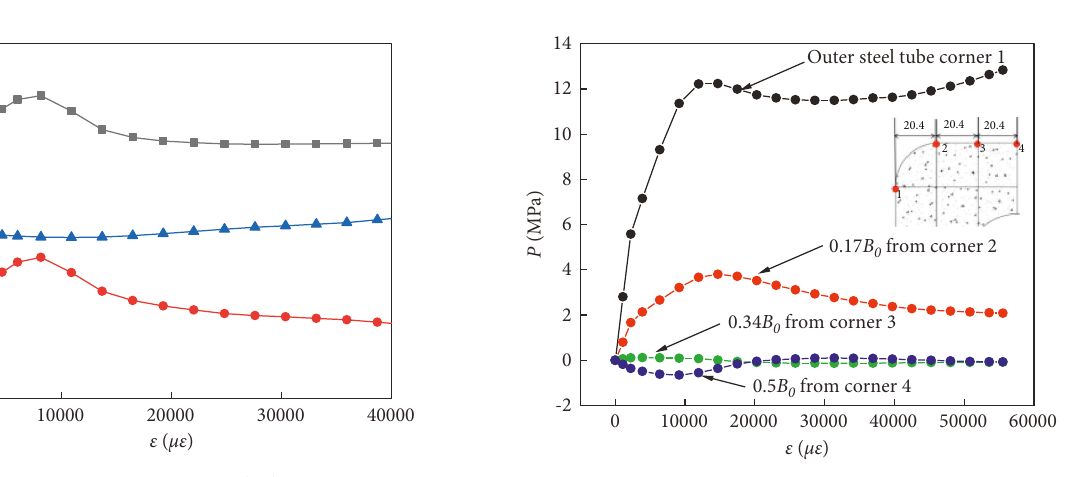
Figure 15: Change of restraining force at different positions of the section in